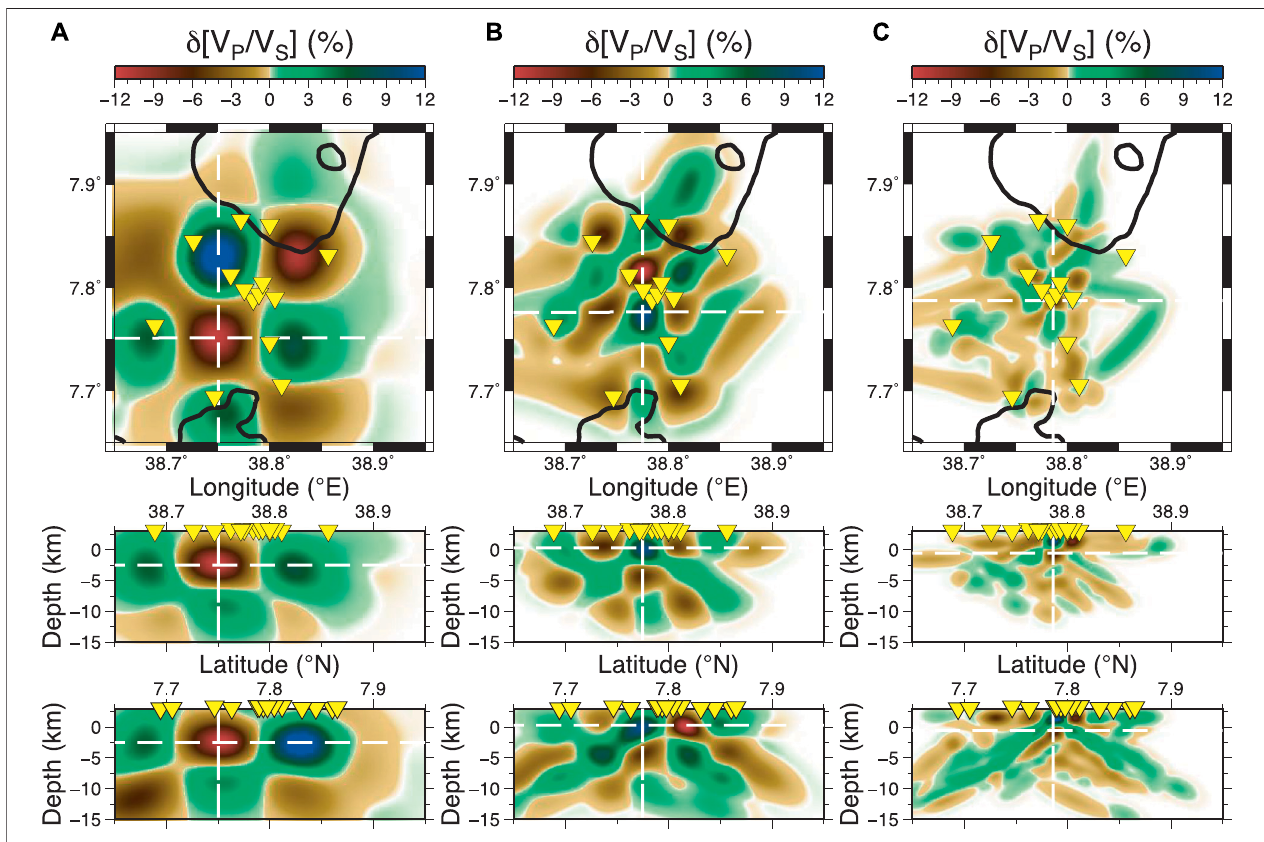
FIGURE 4 | Checkerboard recovery results for V P / V S of differing checkerboard scale lengths (A – C) . Compare with input checkerboard structure shown in Figure 3 . See Supplementary Figures 4.1 – 4.5 for equivalent V P and V S checkerboard test results.